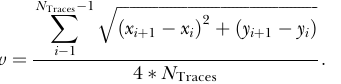
Figure S1. Comparative Chromosomal Arrangement of Metal Resistance Cluster Genes in H. arsenicoxydans and R. metallidurans The synteny region between two species was defined to include both conservation of the gene content and order. Genes in the R. metallidurans genome were predicted from the DOE Joint Genome Institute data. In the absence of complete functional studies, in particular the detection of transcription terminators, we assume that each cluster is represented by the longest DNA segment delimited by conserved ORFs in at least one of the clusters. The genes present in each cluster are indicated by arrows (not drawn to scale) indicating the direction of transcription. The genes of conserved synteny are identified by color coding and labeled with the annotation gene names. (A) Cadmium-zinc-cobalt–resistance operons. (B) Copper-resistance operons. (C) Chromate-resistance